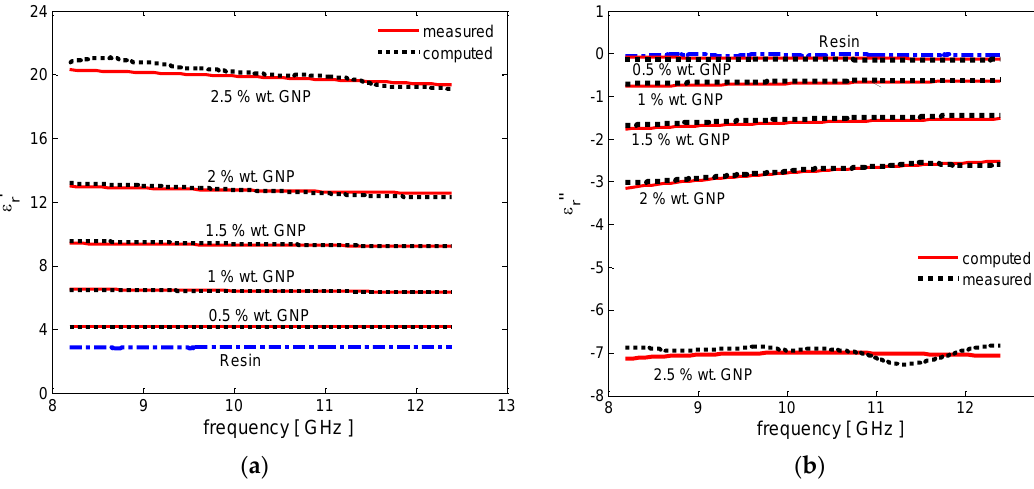
Figure 9. Complex effective permittivity of the GNP-filled vinyl ester-based composites with increasing filler concentrations: ( a ) real part and ( b ) imaginary part.